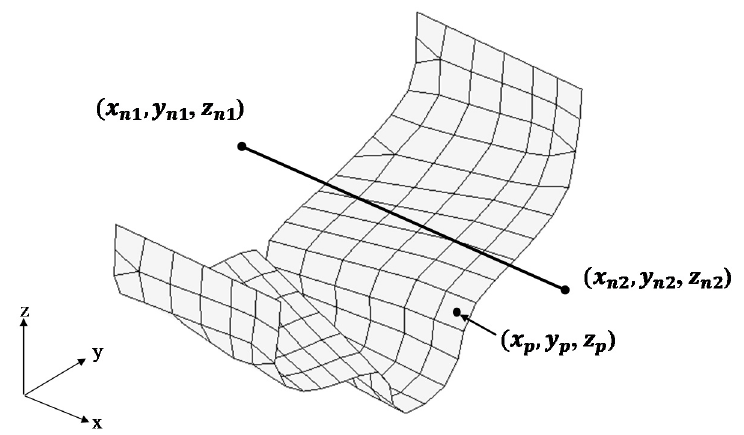
Figure 2. Coupling the beam nodes of 1D beam model and grids of 3D panel model.